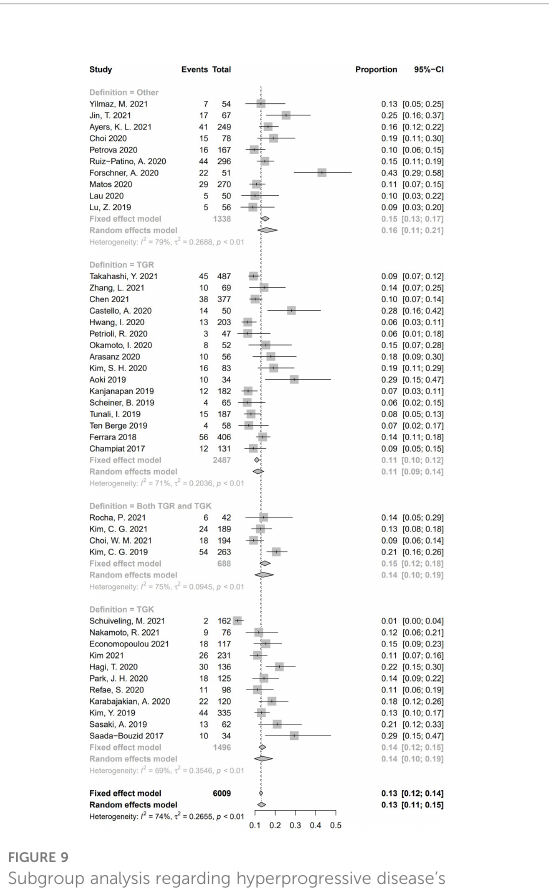
FIGURE 9 Subgroup analysis regarding hyperprogressive disease ’ s de fi nitions and its incidence. CI, con fi dence